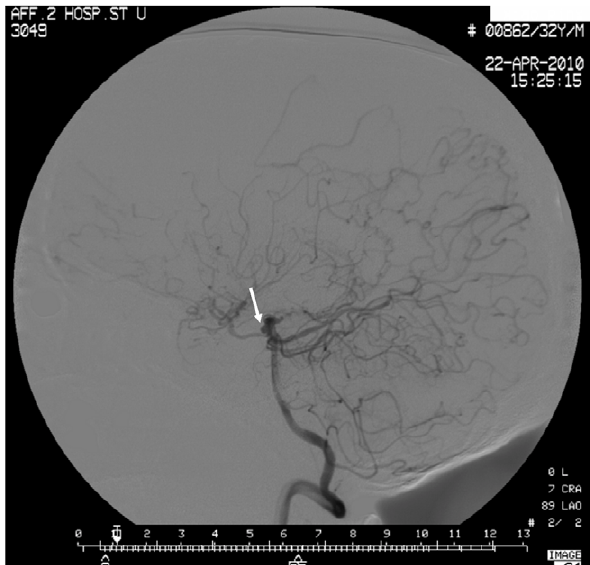
Figure 2. Digital subtraction angiogram (DSA)showing stenosis of the distal portion of the ICA (white arrow).